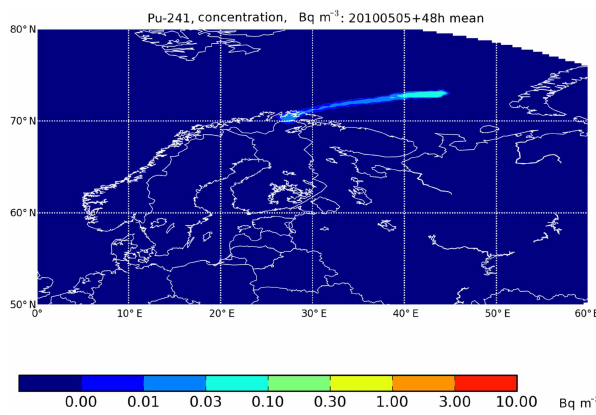
Figure 8. The average activity concentration of 241 Pu in the surface air during the first 48h after a hypothetical accident in a floating reactor at the Shtokman natural gas field, in the Barents Sea, with an assumed release 5 May